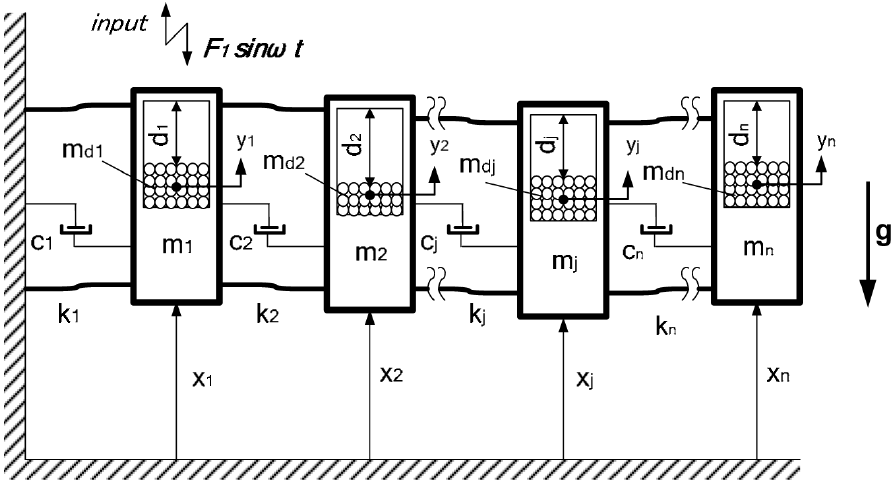
Fig. 1. MDOF system with particle